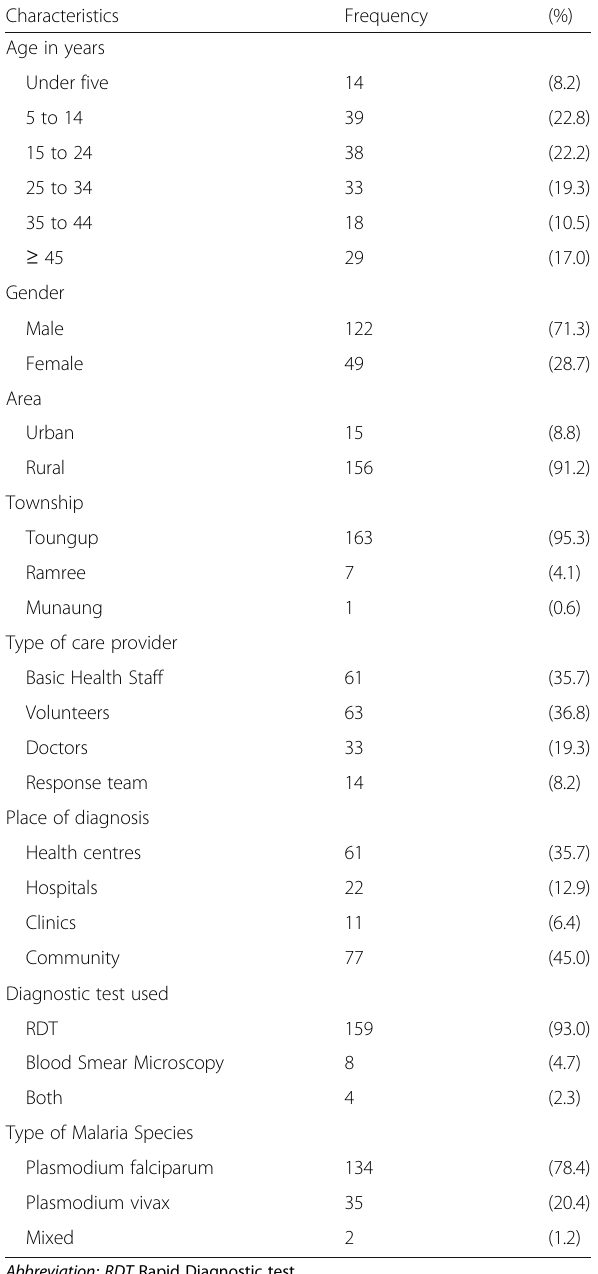
Table 1 Socio-demographic and clinical profile of malaria